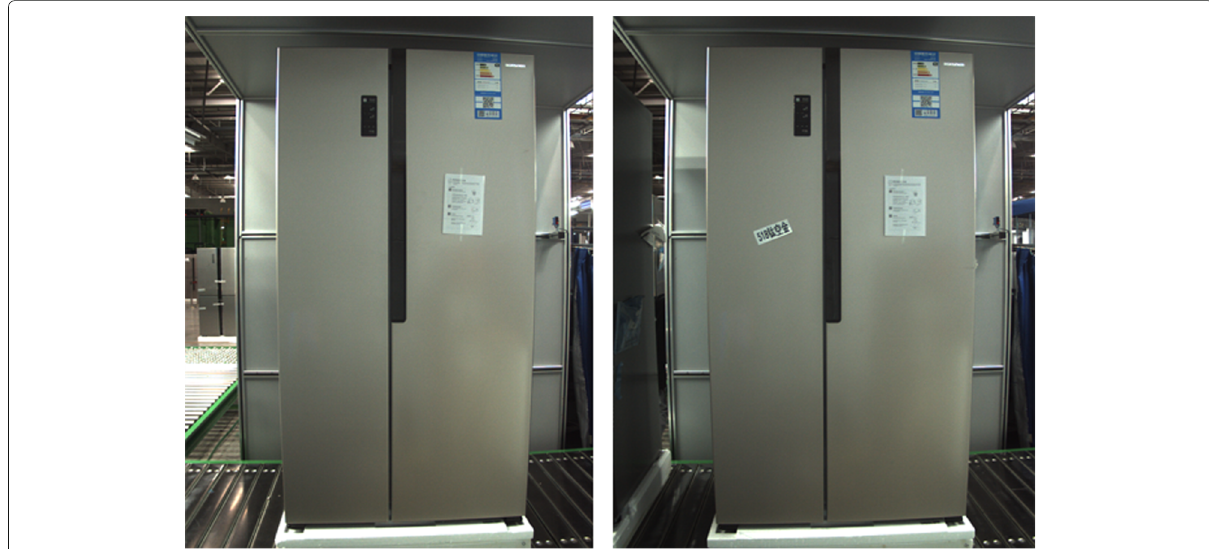
Fig. 2 The varying backgrounds in the front-view images of